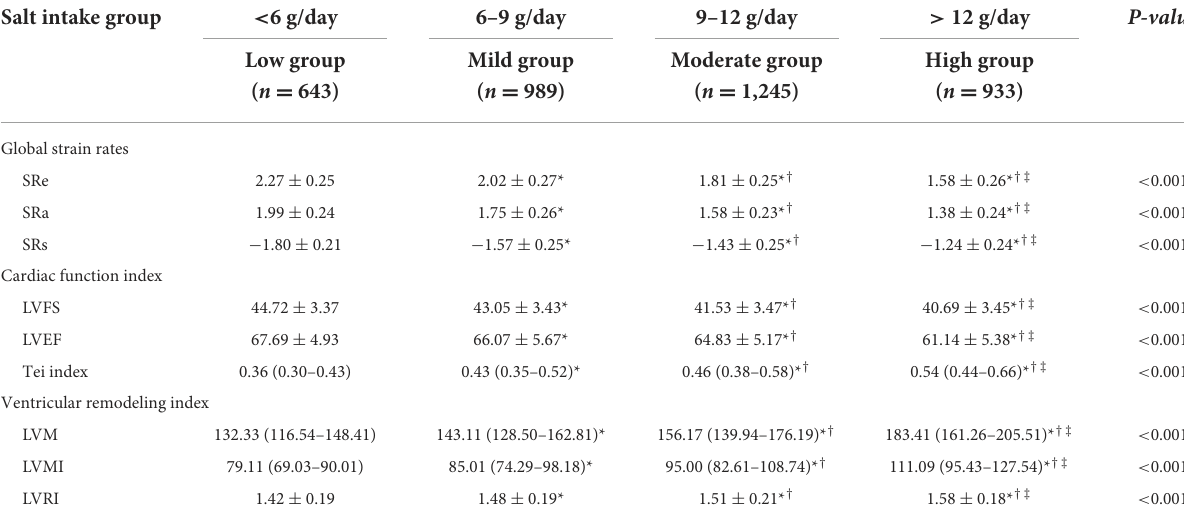
TABLE 2 Differences in the myocardial strain rates and left ventricular structure and function between the four groups.